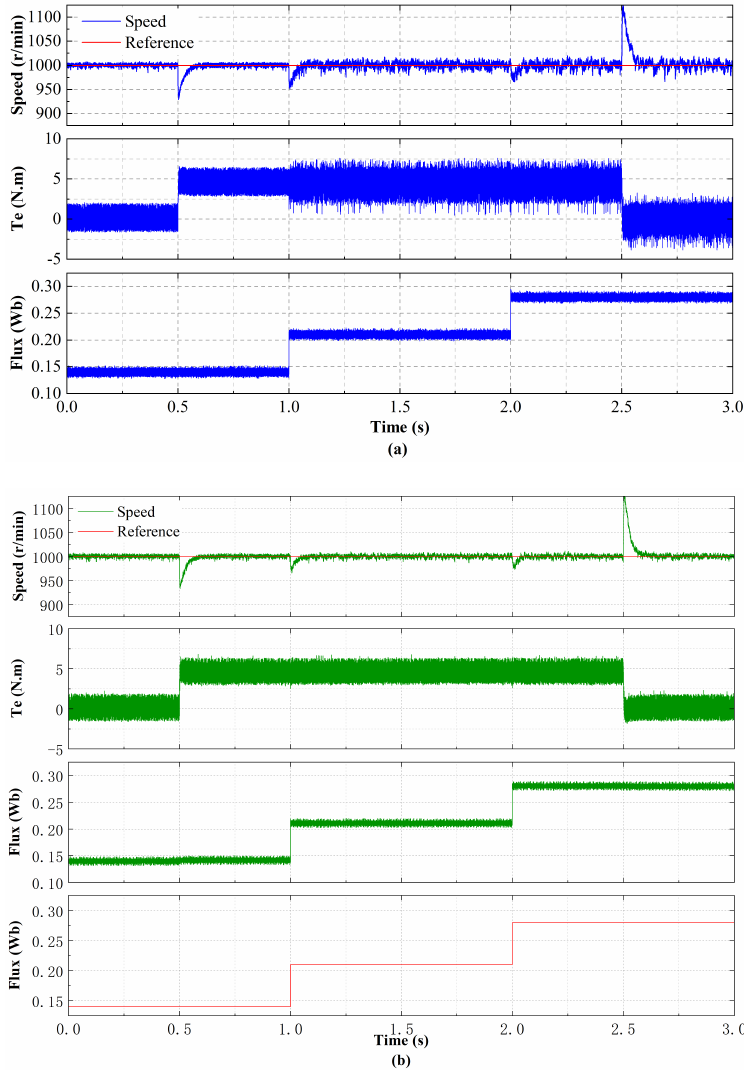
Figure 10. The experimental results of conventional PPTC and proposed MF-PPTC in the case of rotor flux mismatch. ( a ) Conventional PPTC. ( b ) Proposed